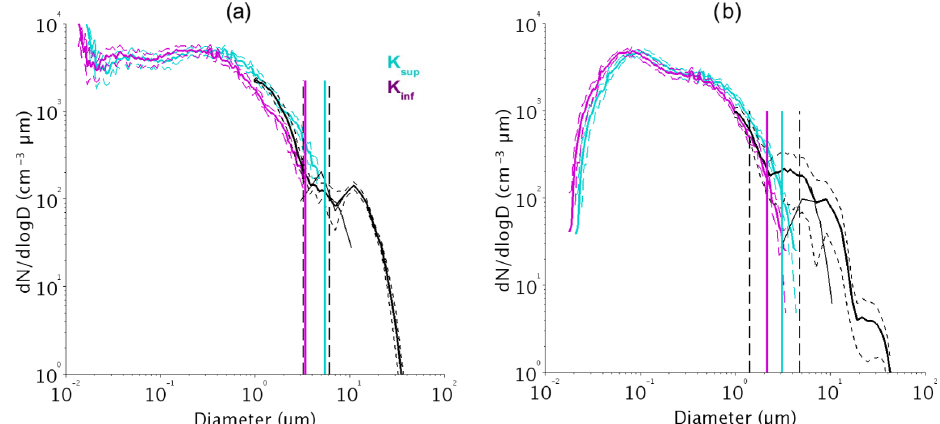
Figure 4. The 1h wet number size distribution before the fog event resulting from the hygroscopic grow at RH = 100% of the dry distribution measured by the SMPS calculated with κ inf (purple) and κ sup (cyan) for cases (a) f6 and (b) f20. The in-fog composite size distribution of Fig. 1 is superimposed (black). The solid lines represent mean values and the dashed lines show ± 1 standard deviation. The vertical segments indicate the mean values of D w corresponding to each κ (solid color lines) and the extreme values (dashed